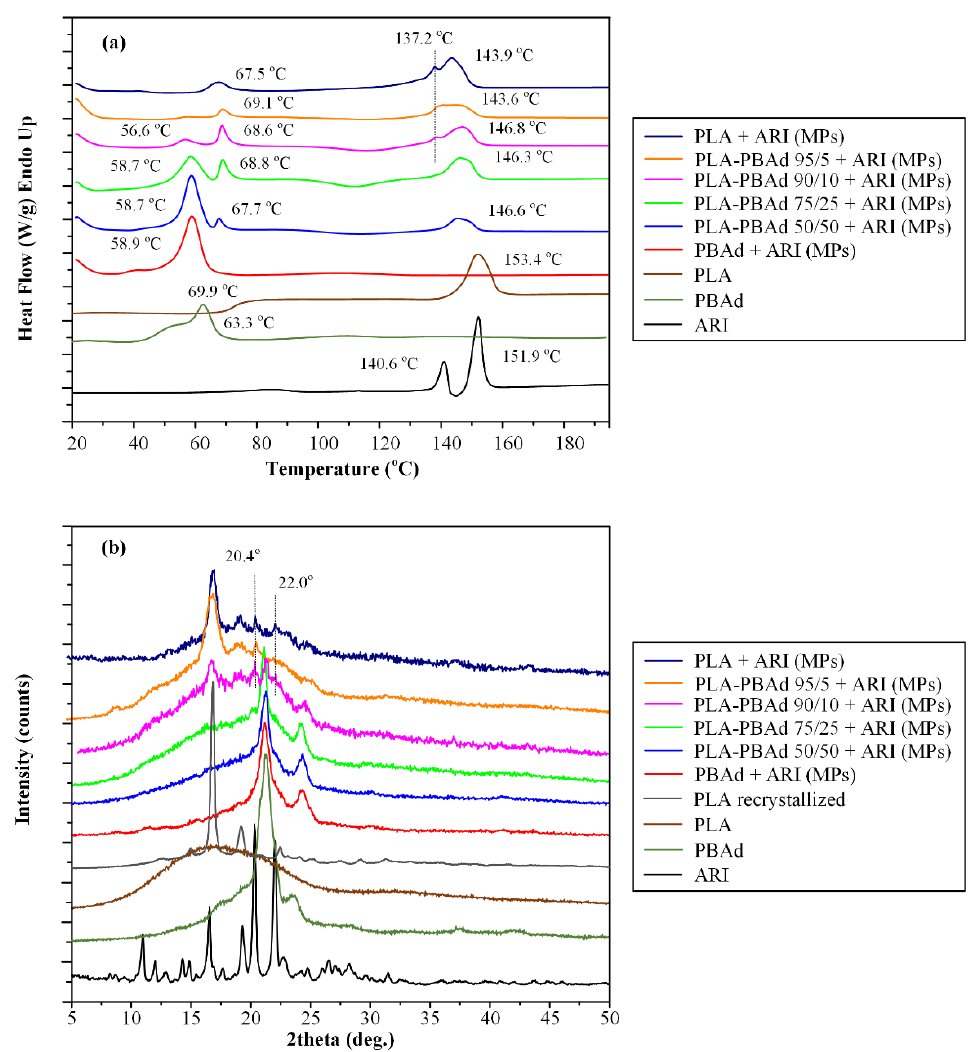
Figure 6. DSC thermograms ( a ) and XRD diffractograms ( b ) of the neat raw materials (i.e., ARI, PLA and PBAd) and the prepared drug-loaded MPs.